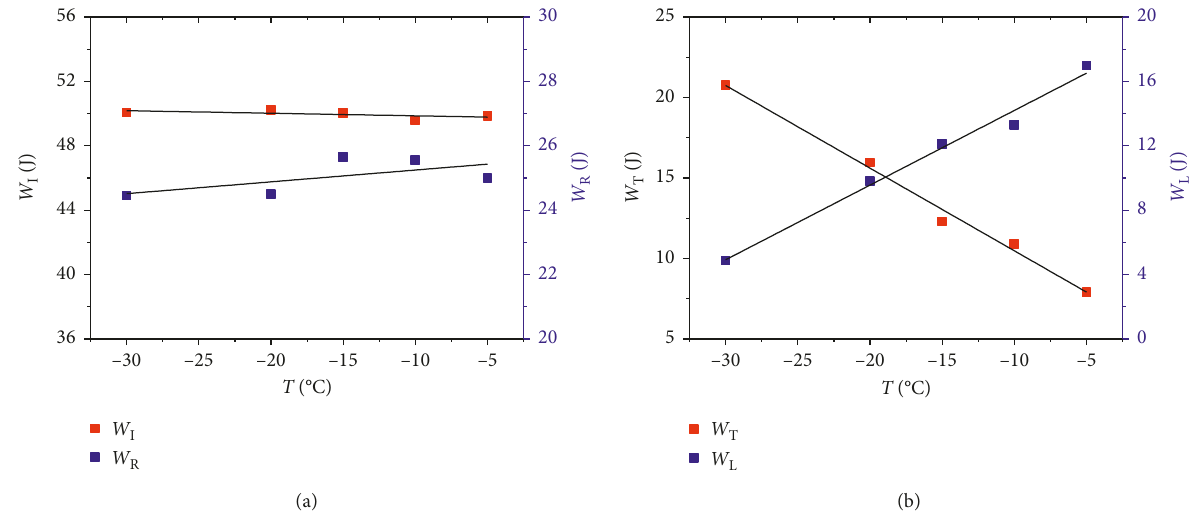
Figure 20: Variation regularity of energy dissipation with different F-T